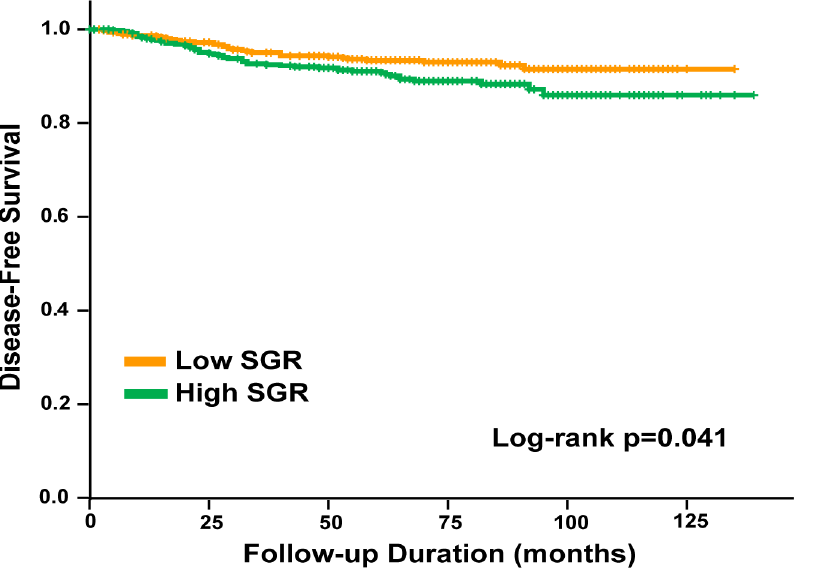
Fig 1. DFS according to low and high SGR (log rank test p = 0.041).